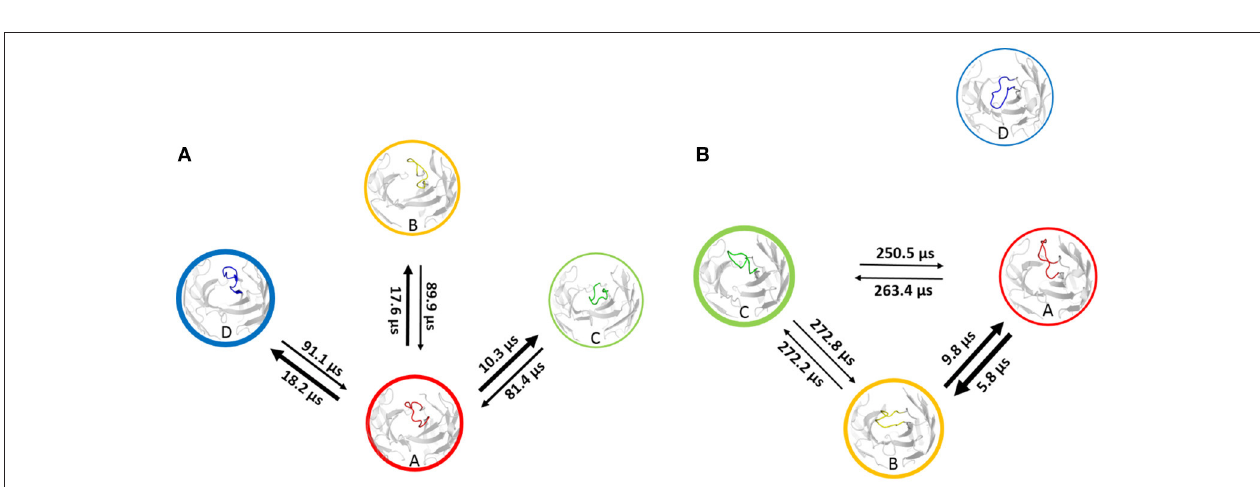
FIGURE 7 | Transition timescales based on a Markov-state model of the promiscuous Fab 249 (A) and the specific Fab 246 (B) antibody. Fab 246 shows significantly higher transition timescales, which indicate higher free energy barriers, compared with the Fab 249.